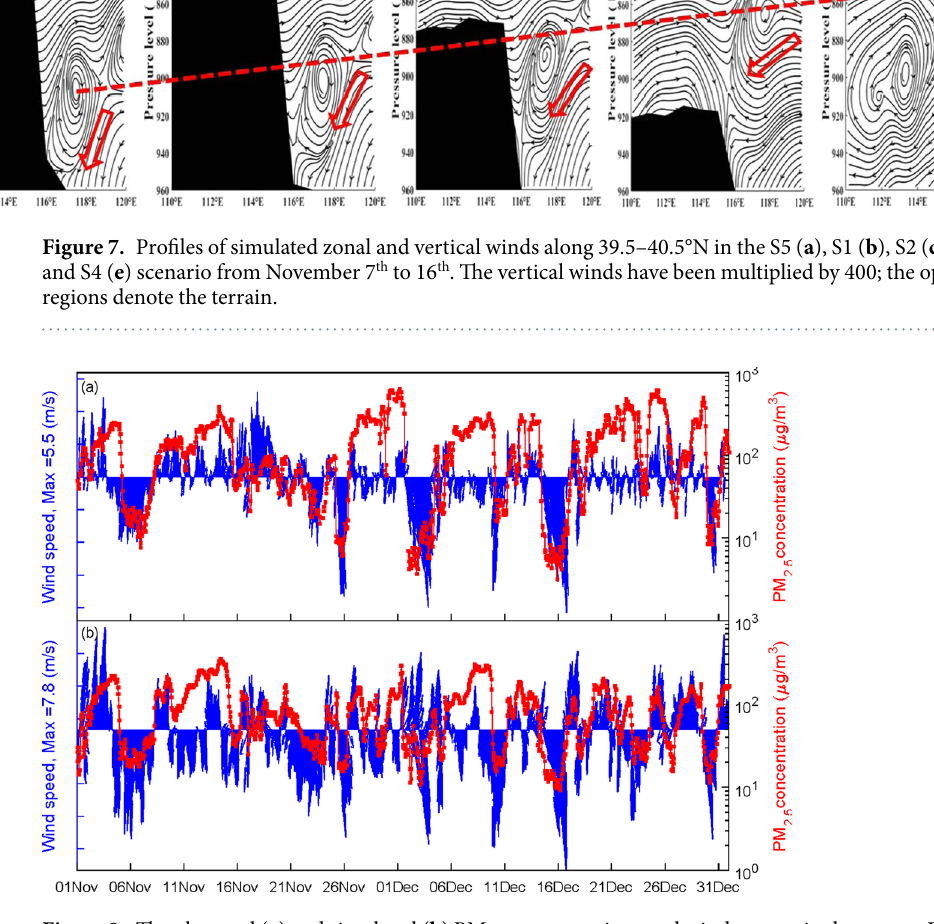
Figure 8. The observed ( a ) and simulated ( b ) PM 2.5 concentrations and wind vectors in downtown